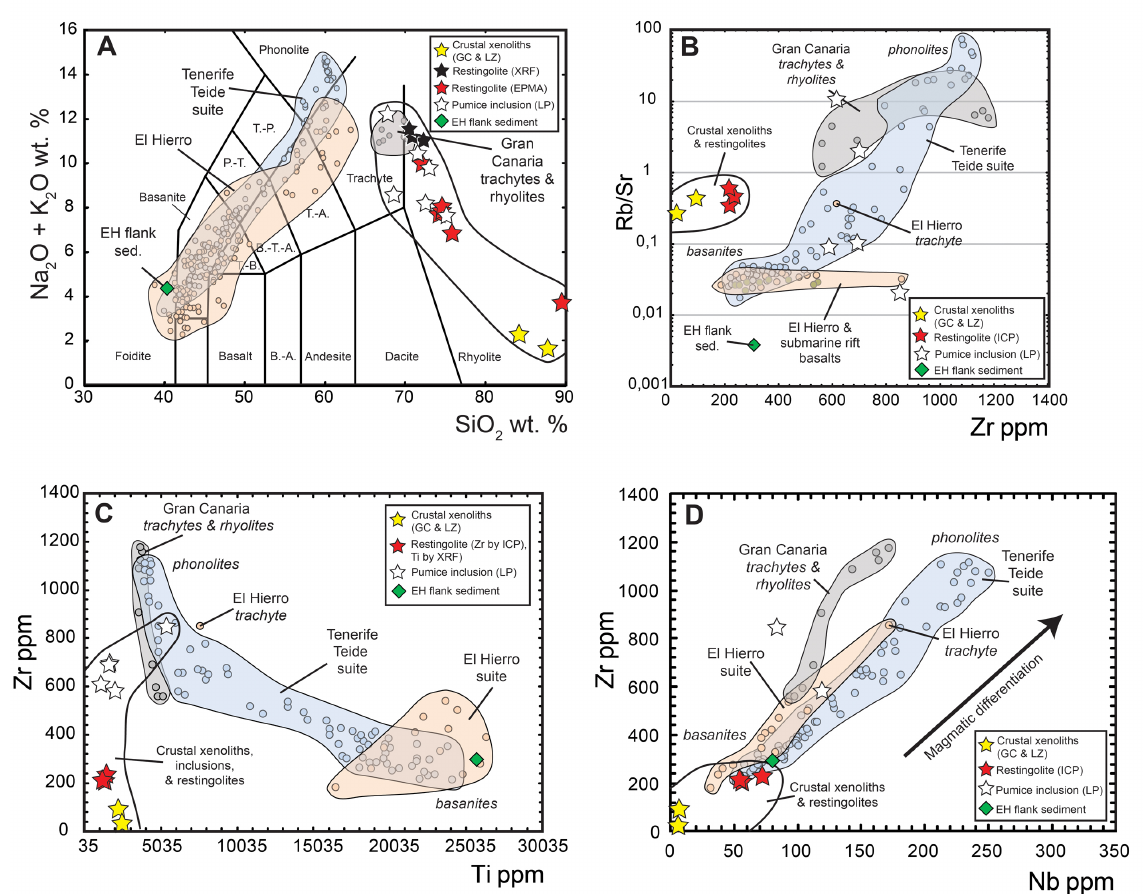
Fig. 5. Geochemical plots of early El Hierro floating stones (“restingolites”) and comparative data for magmatic rocks from El Hierro, Gran Canaria, and Tenerife, and Canary Island crustal xenoliths. (A) Total alkalis versus silica (TAS) plot showing the alkaline Canary Island magma suites. The early El Hierro floating stones plot within the trachyte to rhyolite fields, however, they do not follow a typical Canary Island magmatic trend. Note that known crustal xenoliths from Gran Canaria (Hansteen and Troll, 2003) and Lanzarote (Aparicio et al., 2006) and probable xeno-pumice inclusions from La Palma (Arana and Ibarrola, 1971; Kl ¨ ugel et al., 1999) also plot as rhyolites. (B) Rb/Sr versus Zr plot. The most evolved Canary Island magmas plot to the top right of the diagram. The “restingolites” and crustal xenoliths form a distinct group from both, the least and most evolved magmatic samples. La Palma xeno-pumice inclusions show a large degree of scatter, and do not follow any distinct magmatic trend. (C) Zr versus Ti (ppm) plot, showing the main Canary magmatic trends (Tenerife, El Hierro and Gran Canaria) and the composition of the crustal xenoliths and the early El Hierro floating stones. Note that the magmatic samples on the one side form a distinctly different trend to that of the crustal compositions from Gran Canaria, Lanzarote, La Palma, and the early El Hierro “restingolites” on the other. (D) Zr versus Nb plot. Canary Island igneous suites show strong magmatic differentiation trends, with the most evolved samples plotting to the top right of the diagram (i.e. at high Zr and Nb concentrations). In contrast to the TAS plot, early El Hierro floating stones plot near the least evolved magmatic samples. The chemical data thus underline that early El Hierro floating stones are highly atypical for Canary magma compositions and chemically resemble known sedimentary xenolith and pre-island sedimentary compositions once the full major and trace element compositions are considered. Reference data fields El Hierro (Pellicer, 1979; Carracedo et al., 2001), Gran Canaria (Hoernle, 1998; Troll and Schmincke, 2002), Tenerife (Rodriguez Badrola et al., 2006; Wiesmaier, 2010). Abbreviations: GC, Gran Canaria; LZ, Lanzarote; LP, La